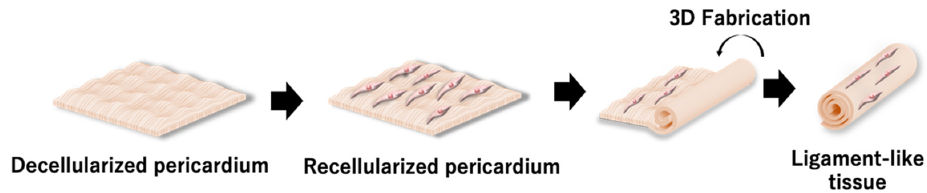
Figure 1. Scheme of a 3D tissue reconstructed using the recellularized pericardium.